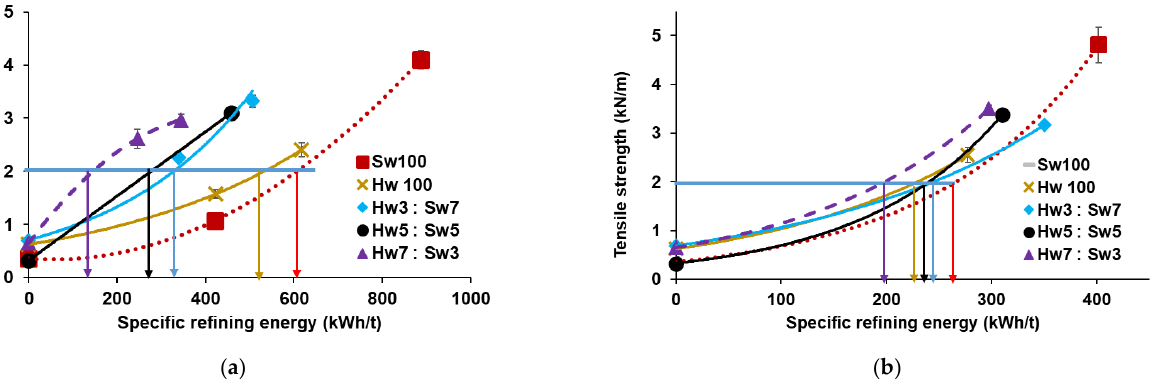
Figure 11. Effect of CEL on tensile strength of paper made of mixed pulps: ( a ) PA55; ( b ) PB97. In the case of PA55, the refining energy for the mixed pulps of Hw-BKP and Sw-BKP required up to the same tensile strength was less than the energy for the independent refining of Sw-BKP and Hw-BKP. PB97 also showed a similar trend, but the refining energy required for the same tensile strength was less than that of PA55. The tensile strength in the target freeness was greater in PB97 than in PA55, irrespective of the mixing ratios of Sw-BKP and Hw-BKP. As more Sw-BKP was mixed, greater refining energy in PB97 was required at the same tensile strength [3]. It was finally confirmed that the fine bar plate with a very large CEL was highly advantageous in strength development and energy saving.